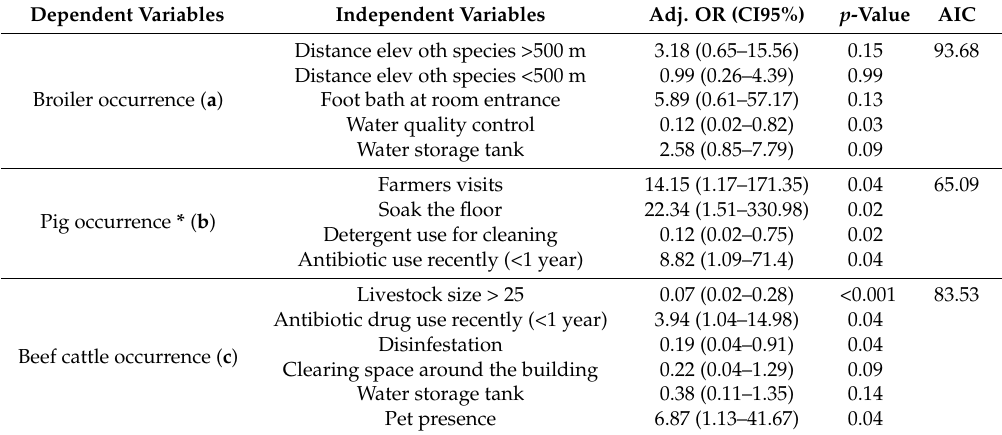
Table 6. Best model explaining ESBL-E occurrence in poultry, pig and cow production (including all territories), 2016 −